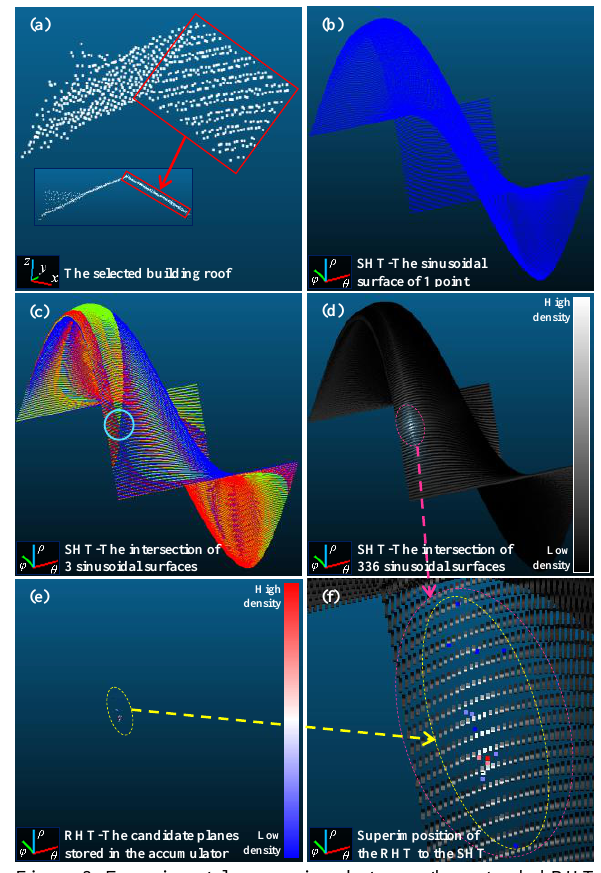
Figure 3. Experimental comparison between the extended RHT and